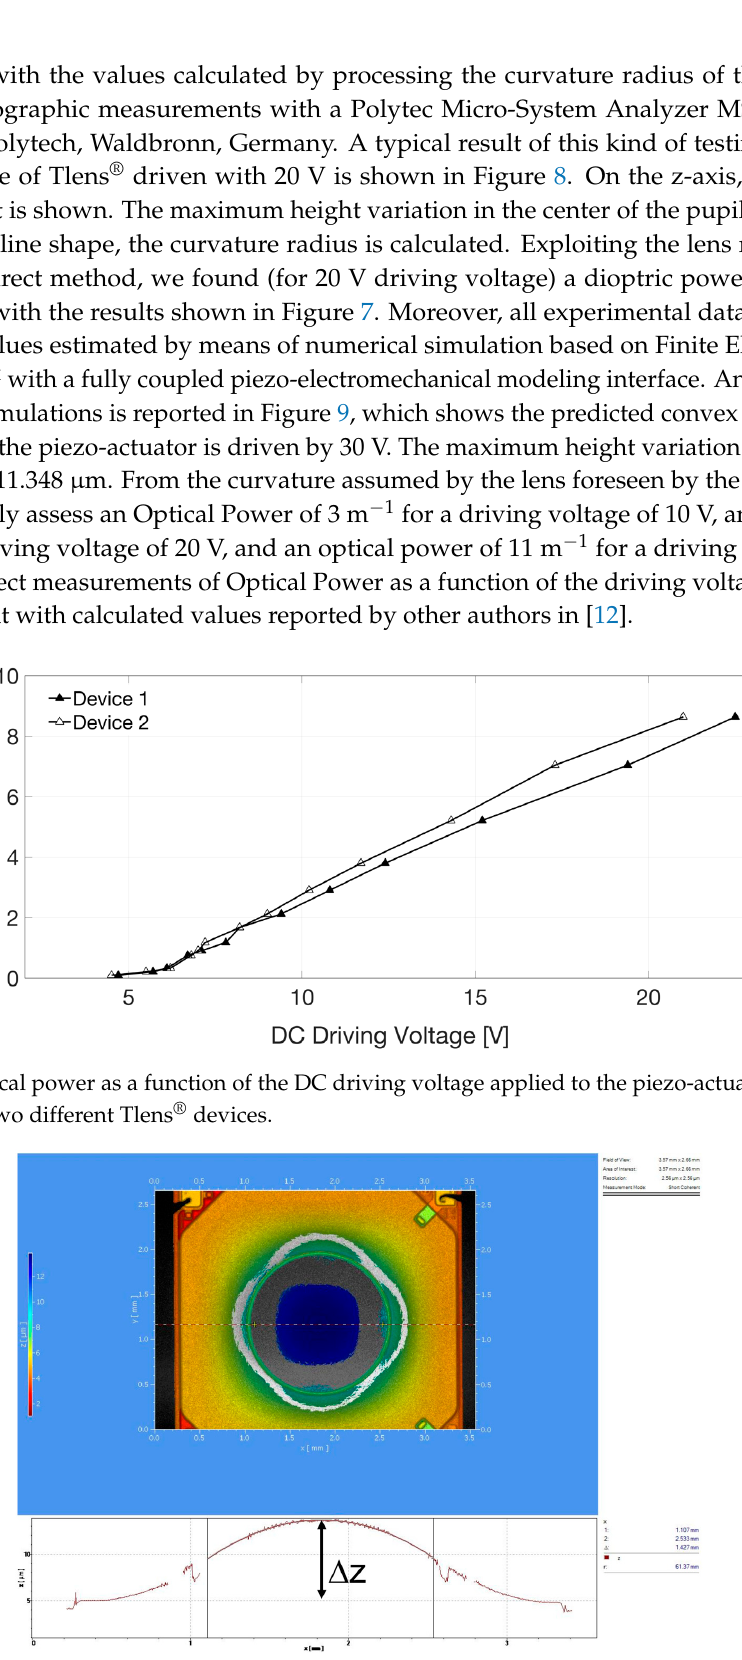
Figure 9. Results of a numerical simulation, based on Finite Element Method using COMSOL™, which predicts the convex shape assumed by the lens when the piezo-actuator is driven with 30 V. On the right, the false color scale for the height reached by the deformed surface of the lens is shown. The maximum height variation in the center of the pupil is Δ z = 11.348 µm. 7. Conclusions We have reported the results of the experimental characterization of Tlens ® tunable micro-lenses by means of a versatile spot optical measuring system. A few samples were investigated to show device performances and potential of the measuring configuration. Comparisons of our results with expected design data was mainly qualitative since fine details relative to the characteristic dimensions of the device were only approximately known. Future work will be devoted to directly confronting the expected performances obtained by numerical modeling and calculations with the experimental results on fabricated devices with well-known geometric parameters.